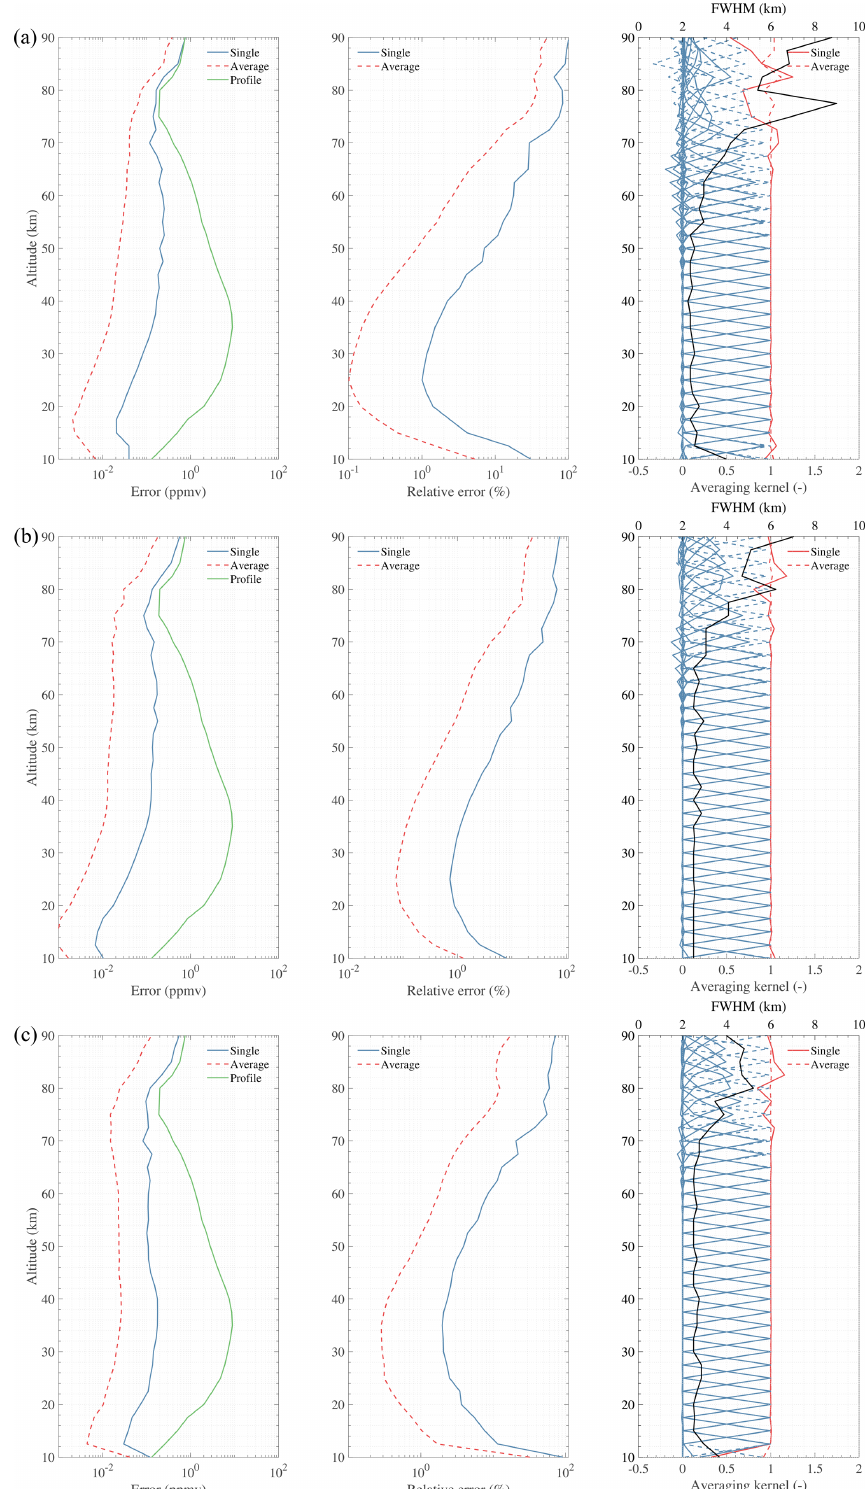
Figure 14. Simulation results of O 3 retrieval using 190 (a) , 235.7 (b) , and 657.5GHz (c) lines. “Single” and “Average” represent the retrieval error using different noise. “Profile” represents the typical profile used in the simulation. The black solid line in the last panel represents the FWHM (i.e. vertical